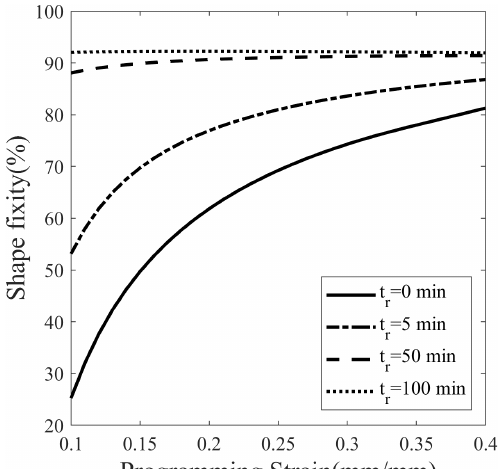
Figure 20. Effect of the programming strain on the shape fixation of SMP at different stress relaxation times ( t r